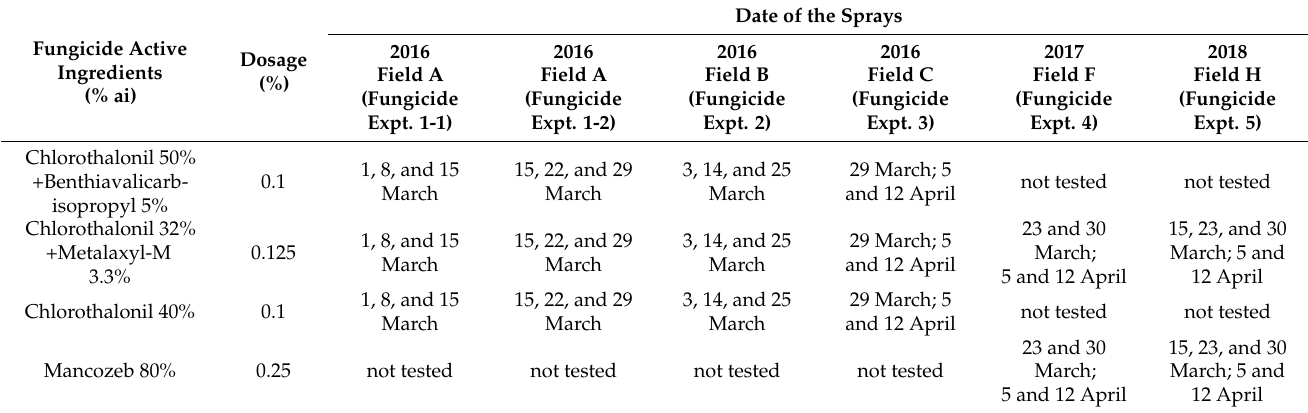
Table 2. List of the fungicides included in fungicide experiments 1–5, doses, and dates of spray a